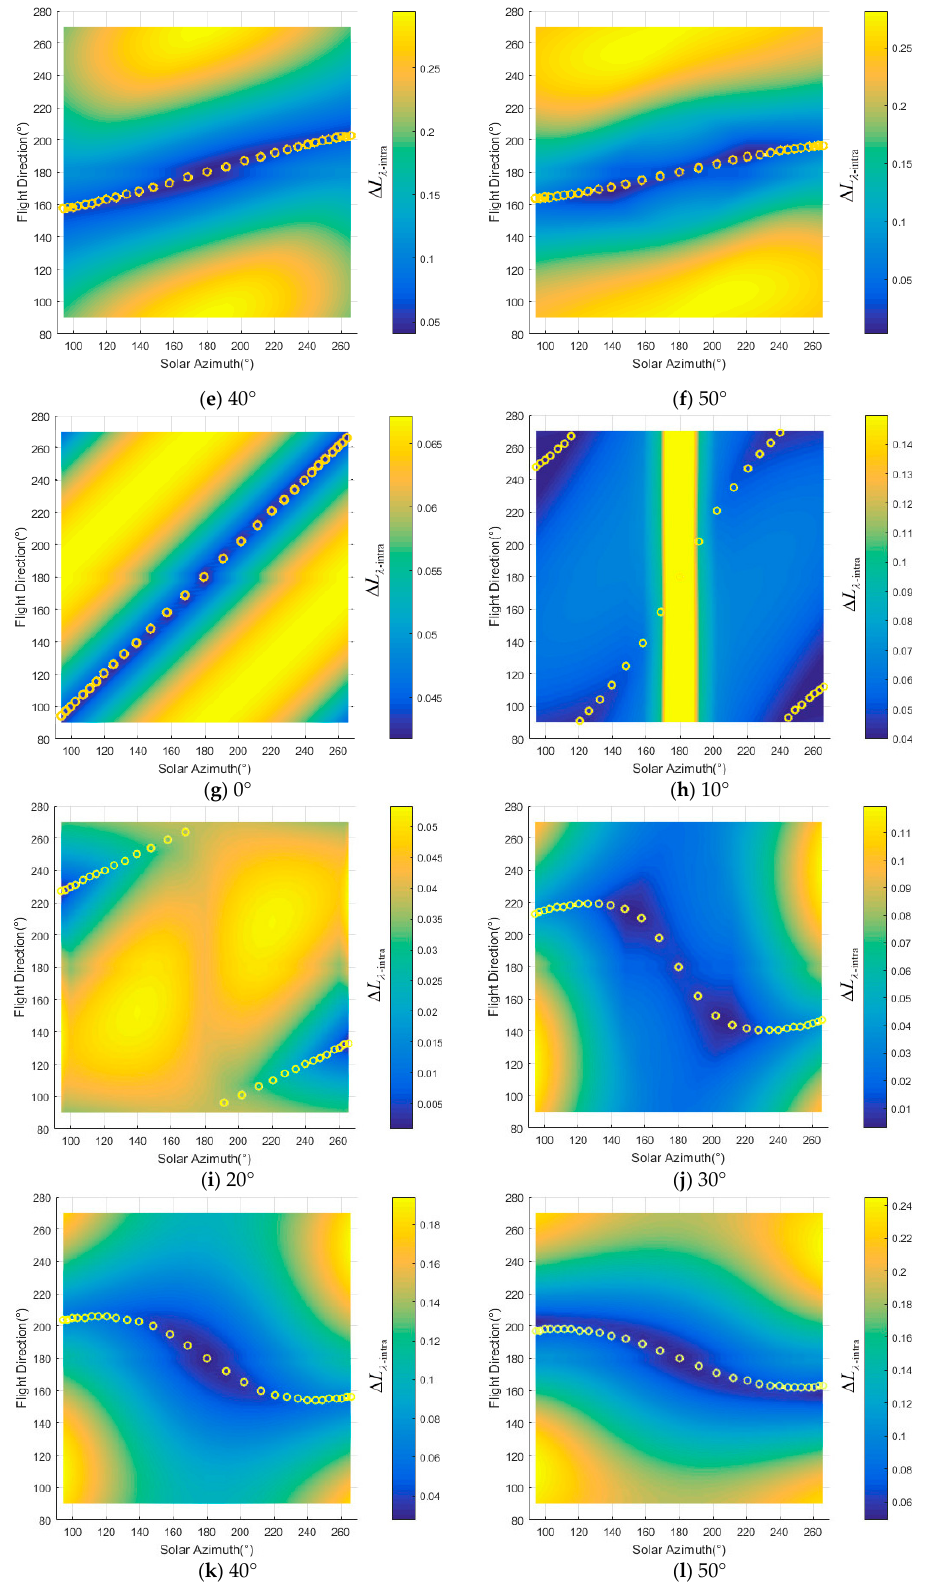
Figure 4. Radiance gradient in the image under di ff erent flight direction and solar azimuth: ( a )–( f ) the radiance gradient when aspect is 0 ◦ and slopes are 0 ◦ to 50 ◦ respectively, ( g )–( l ) the radiance gradient when aspect is 180 ◦ and slopes are 0 ◦ to 50 ◦